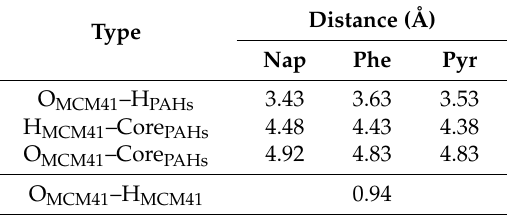
Figure 6. Radius distribution function for ( a ) Nap, ( b ) Phe, and ( c ) Pyr. ( 1 ) O atoms on MCM-41 and H atoms on PAHs, ( 2 ) H atoms on MCM-41 and C atoms on PAHs, ( 3 ) H atoms on MCM-41 and centers on PAHs, and ( 4 ) O atoms on MCM-41 and centers on PAHs. Table 2. Distances between the H or O atom of MCM41 model and CoreX of the three PAHs.